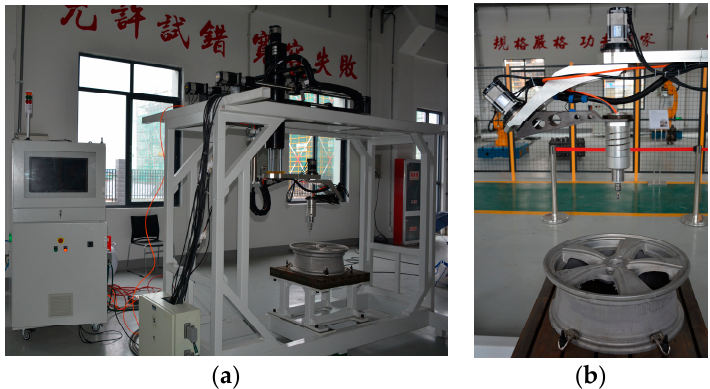
Figure 15. Experimental platform and automobile hub: ( a ) original experimental platform of robot manipulator; ( b ) automobile hub workpiece. Appl. Sci. 2019 , 9 , x FOR PEER REVIEW